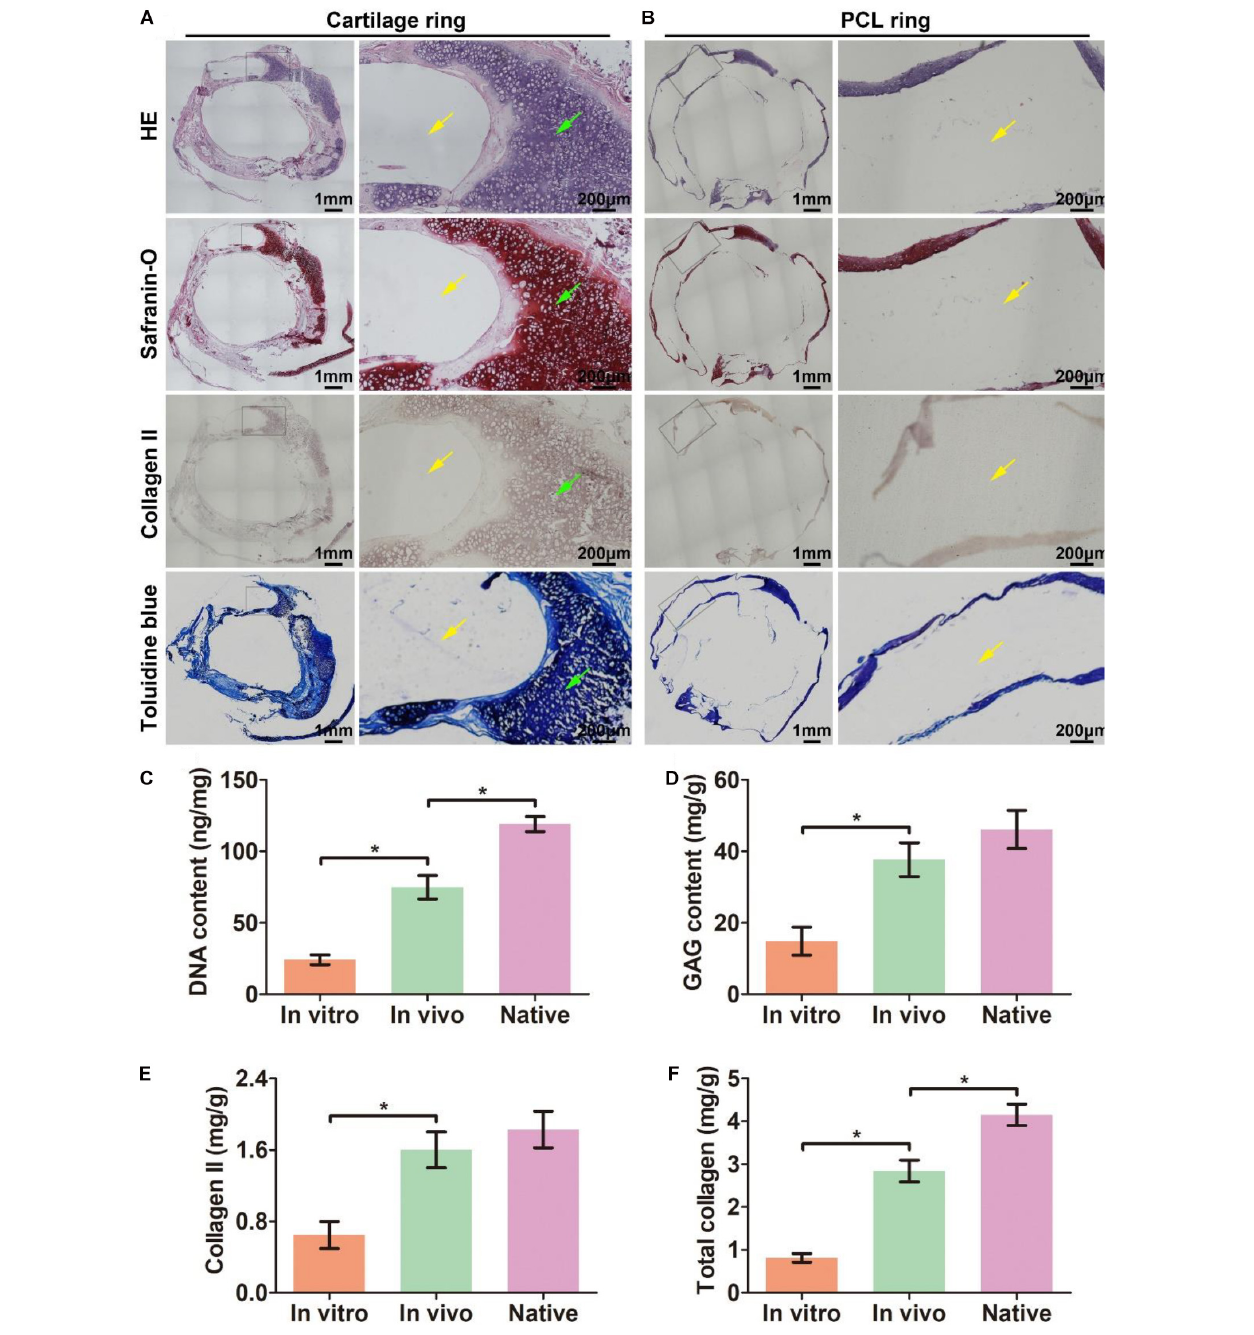
FIGURE 5 | Histological analysis of a transverse section of in vivo engineered biomimetic trachea and biochemically quantitative evaluation. HE, safranin-O, collagen II, and toluidine blue staining of a transverse section of the in vivo engineered biomimetic trachea and representative magnified images of the cartilage ring (A) . HE, safranin-O, collagen II, and toluidine blue staining of a transverse section of the in vivo engineered trachea and representative magnified images of the PCL ring (B) . The green arrows indicate cartilage regions, and the yellow arrows indicate PCL regions. Quantitative measures of the DNA content (C) , GAG content (D) , collagen II content (E) , and total collagen content (F) in samples engineered in vitro and in vivo as well as its native tracheal counterpart. N = 3 per group. * P < 0.05.